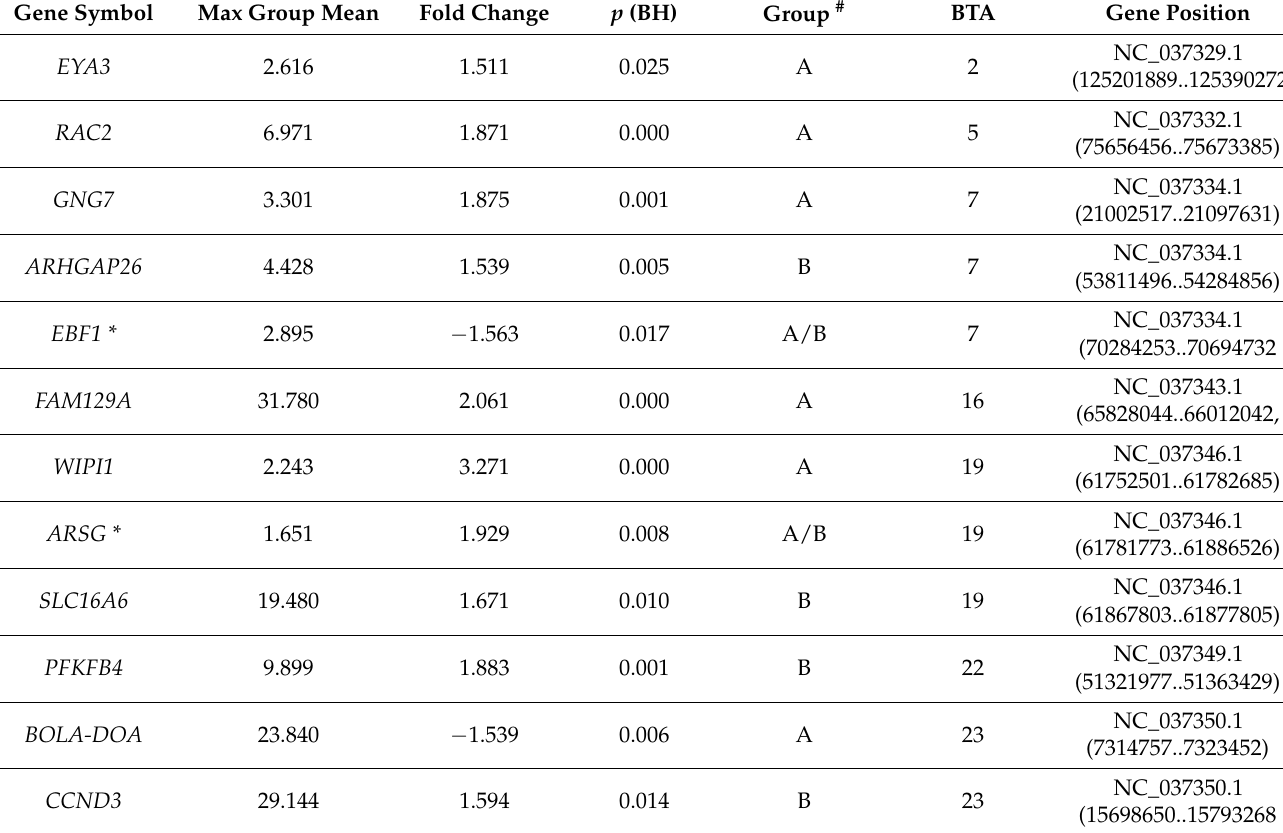
Table 3. Genes with variants present in at least 8 out of 9 samples of E. coli (+) or E. coli ( − ) cows which were also differentially expressed between the EARLY and CONT groups of